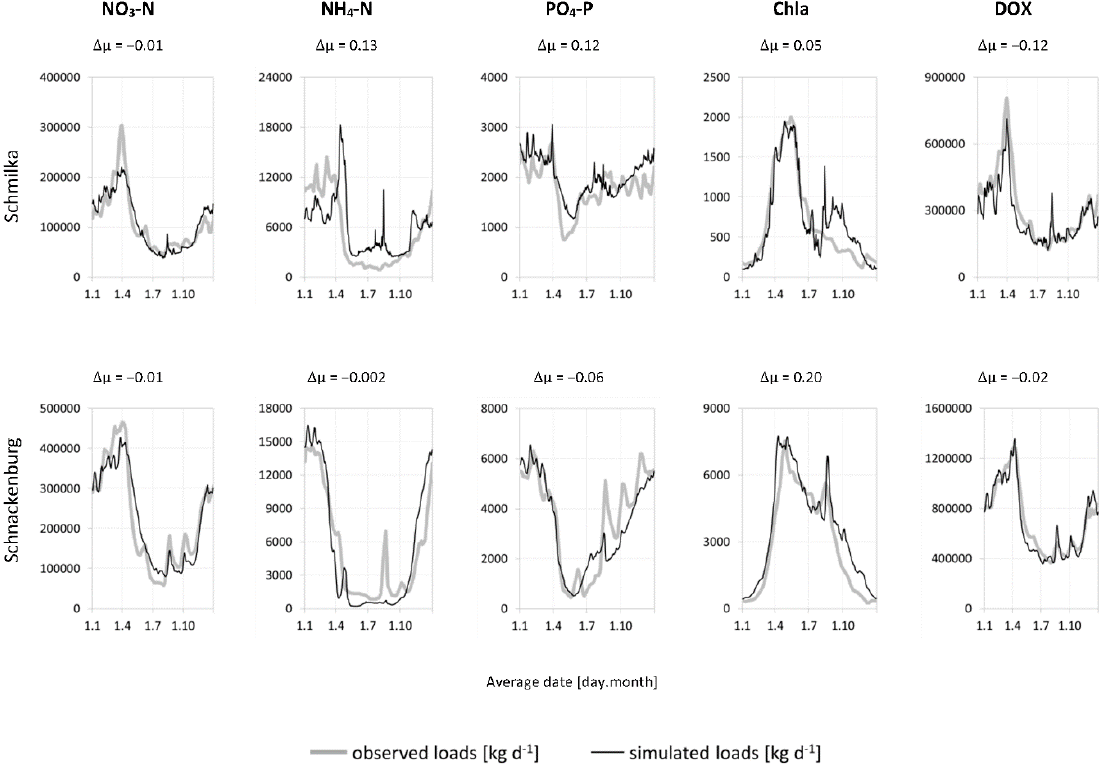
Figure 3. Long-term average daily observed and simulated loads of nitrate nitrogen (NO 3 -N), ammonium nitrogen (NH 4 -N), phosphate phosphorus (PO 4 -P), chlorophyll a (Chla) and dissolved oxygen (DOX) at the two Elbe gauges Schmilka (corresponds to the total Czech loads) and Schnackenburg (most downstream gauge) for the time period 2001–2010.